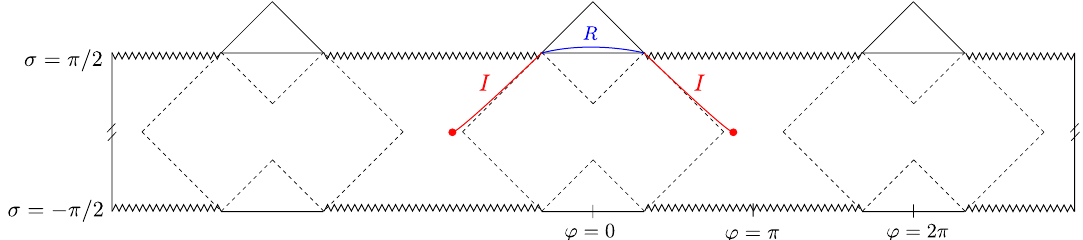
Figure 13. The impure saddle for region R with n = 3